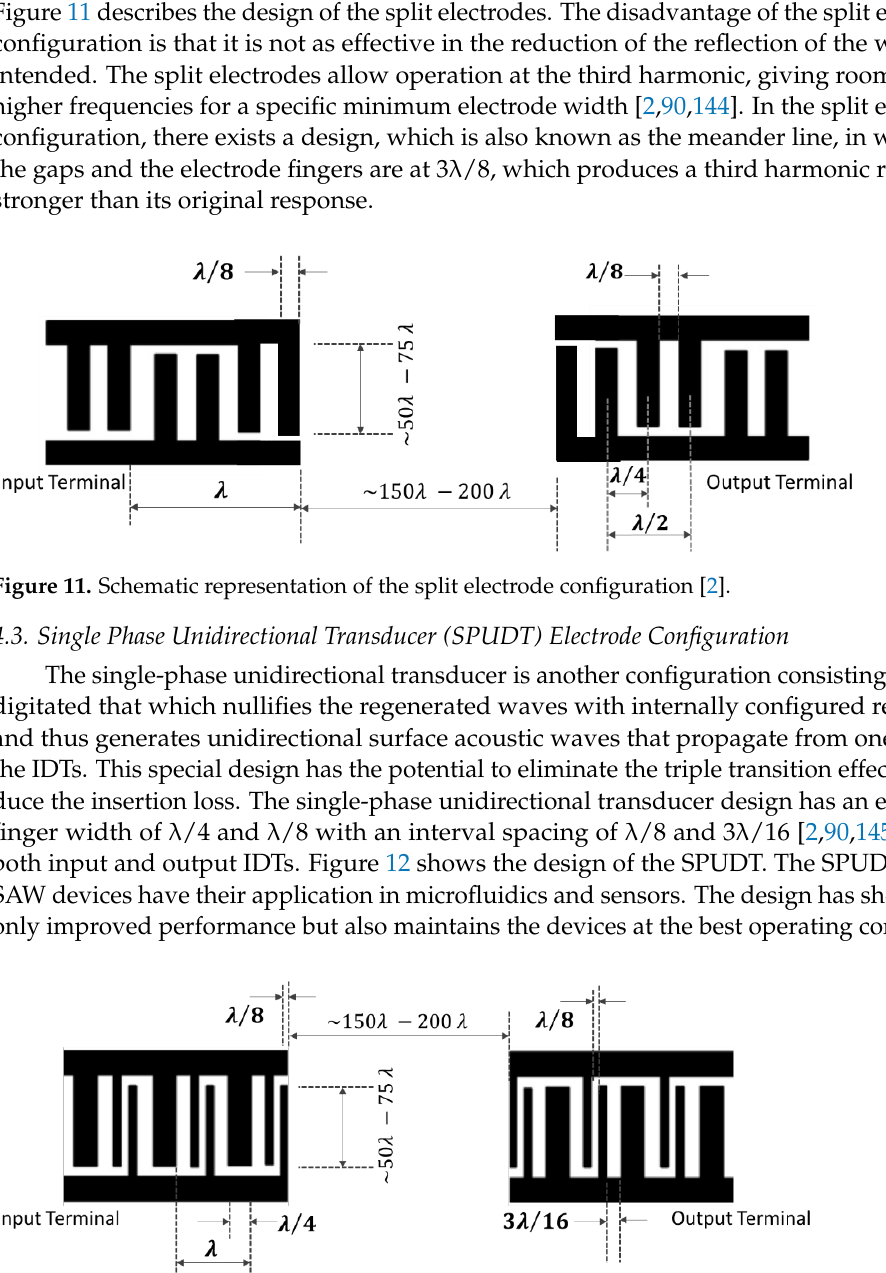
Figure 12. Schematic representation of the SPUDT electrode configuration [2].